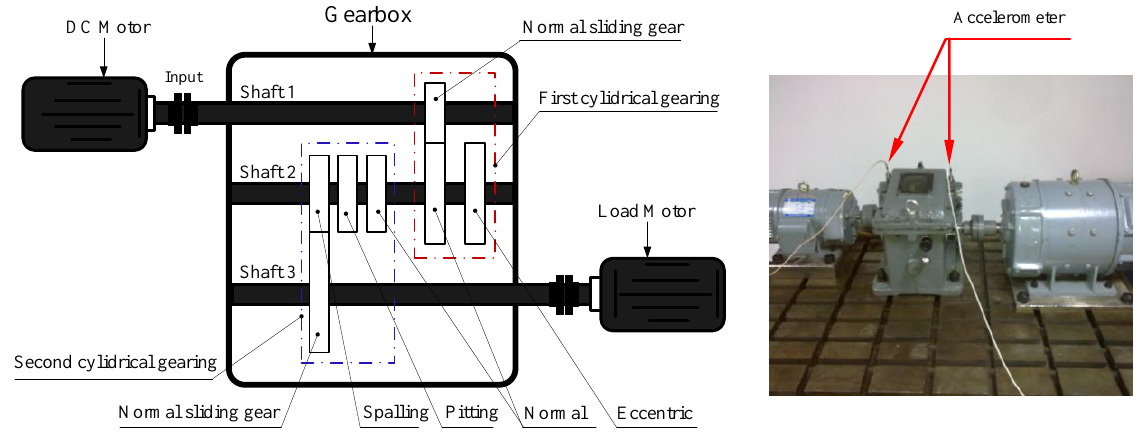
Figure 7. Structure sketch of the test bench for the experimental gearbox.